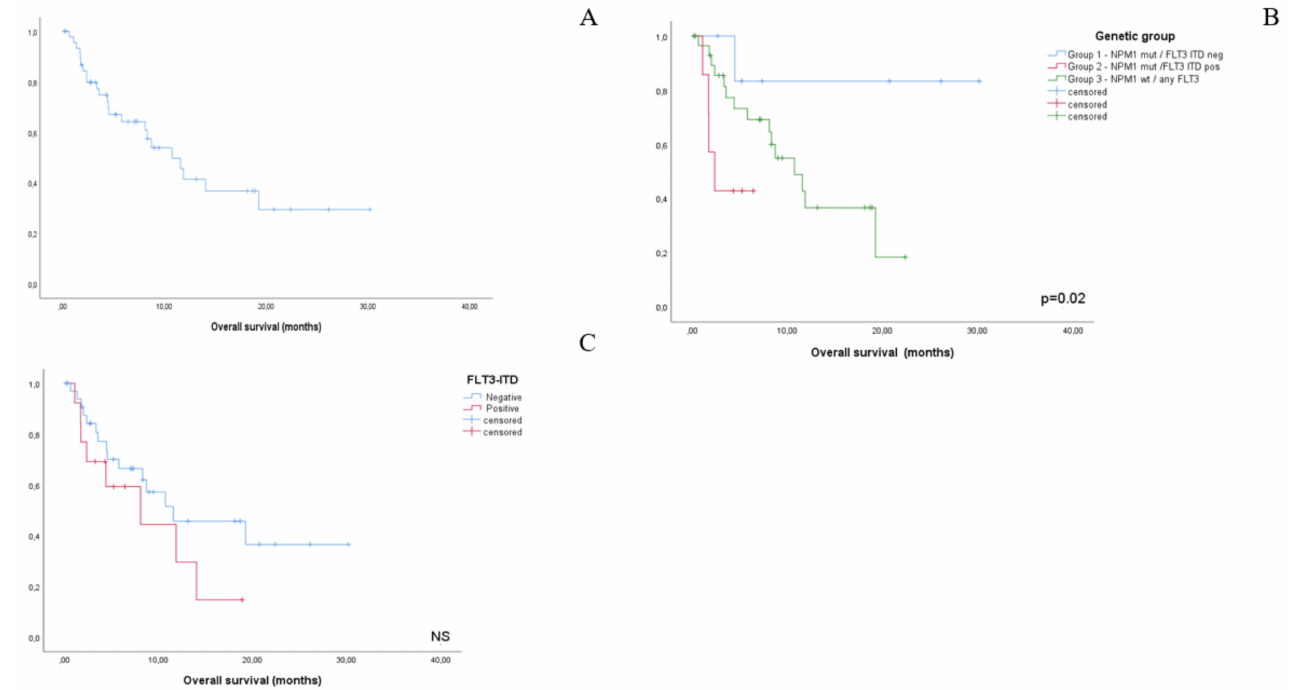
Figure 1. Kaplan-Meier plots representing overall survival for the whole study cohort ( A ), by NPM1/FLT3-ITD-based genetic grup ( B ) and by FLT3-ITD status alone ( C ). Despite not reaching statistical significance, a clear tendency towards a worse outcome for FLT3-ITD positive patients can be noted.